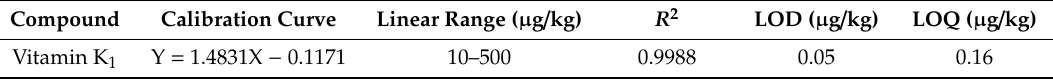
Table 1. Linear equation, determination coe ffi cients, LOD and LOQ for vitamin K 1 .